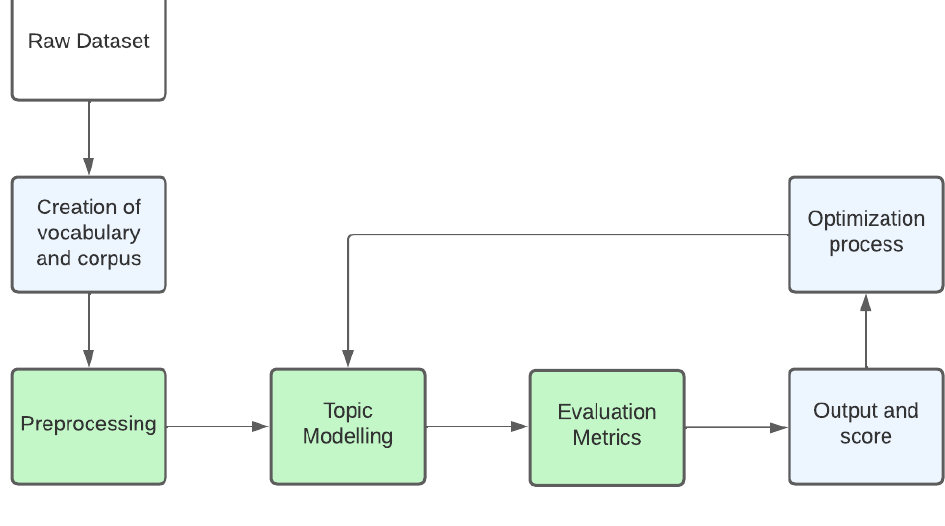
Figure 3. Workflow of the OCTIS